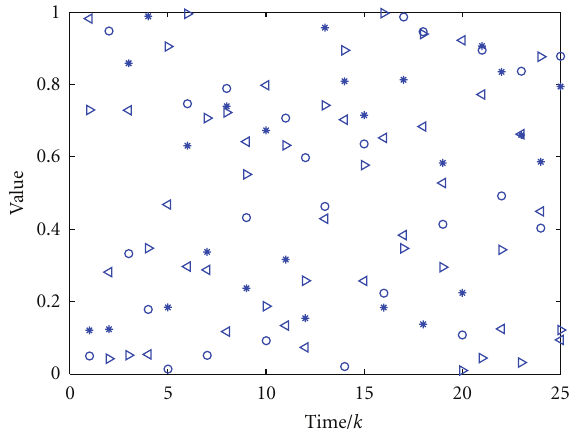
Figure 2: The value of ρ i ( k